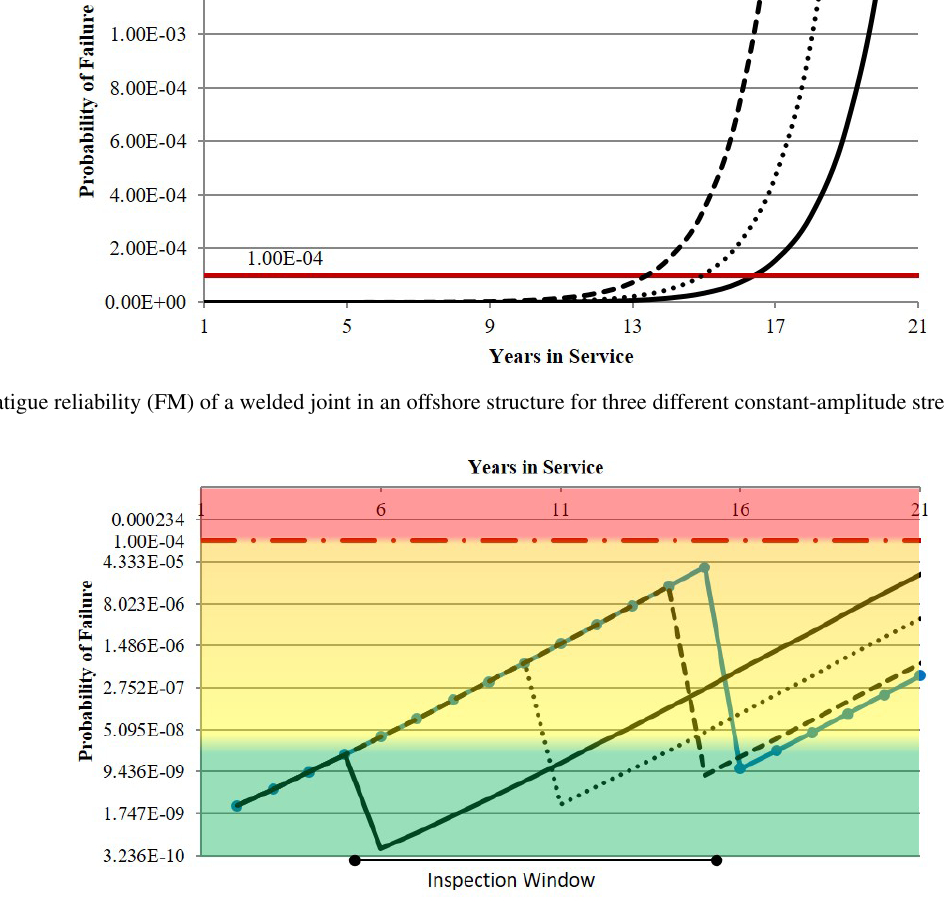
tion. The MPI will allow for thrice the inspection interval window than